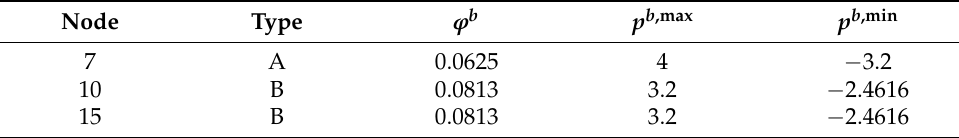
Table 4. BESSs information.